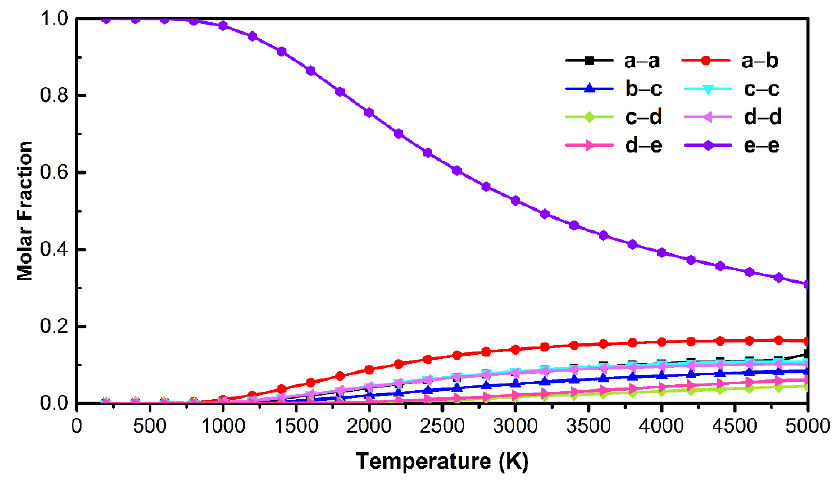
Figure 4. Relative concentrations for the C 71 H 2 isomers, based on the RRHO approximation.